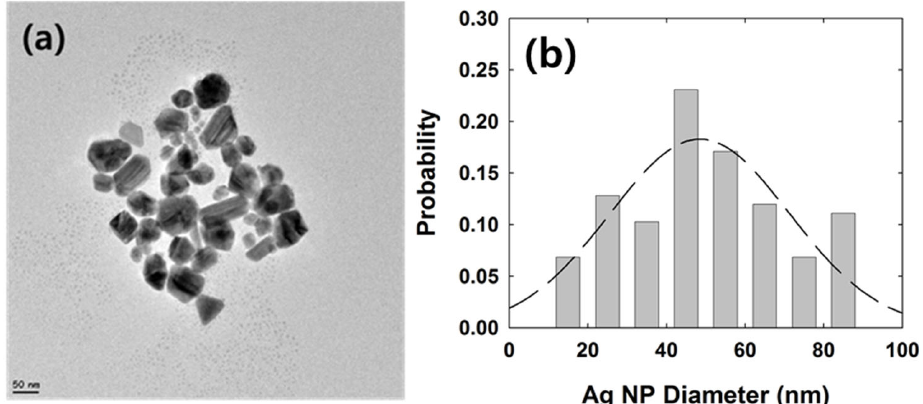
Figure 5. ( a ) TEM image of Ag NPs. ( b ) Size distribution of Ag NPs in TEM image. The average diameter is 50 ± 19 nm. The average surface area of NP is 6.5 × 10 4 nm 3 .